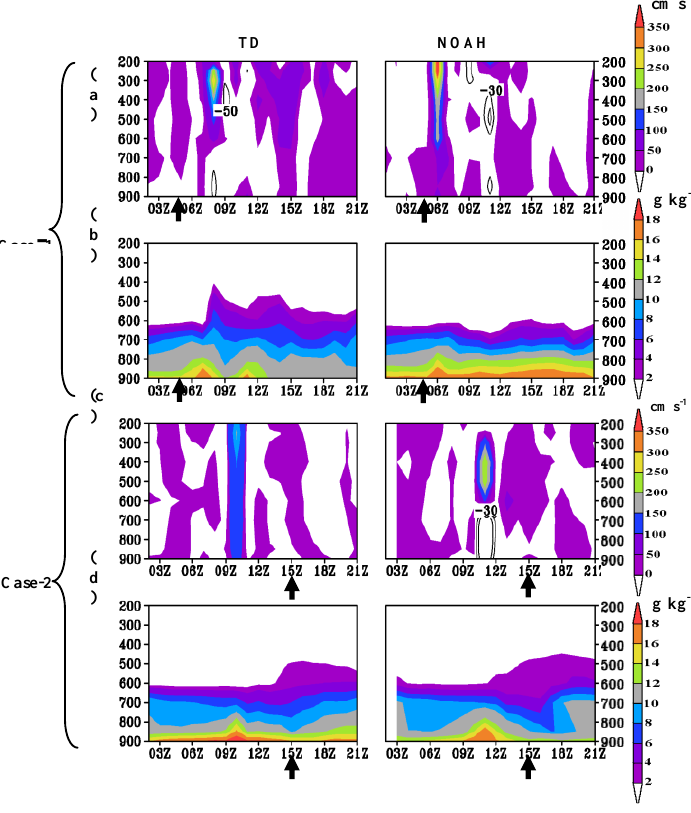
Fig-2: Height-time progression of (a) Vertical Velocity (cm s-1) and (b) mixing ratio (g kg-1) over Kolkata for case-1 for NOAH and TD scheme. (c) and (d) are the same as (a) and (b) but for case-2. Arrow indicates the time occurrence of thunders